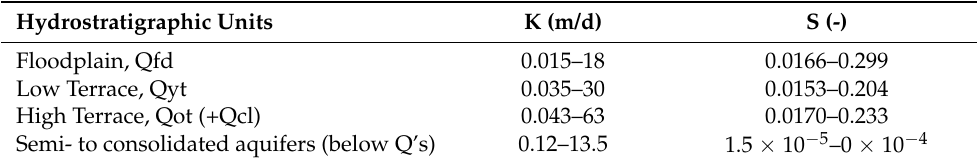
Table 1. Hydraulic conductivities and storage coefficients of grouped hydrostratigraphic units from pumping test